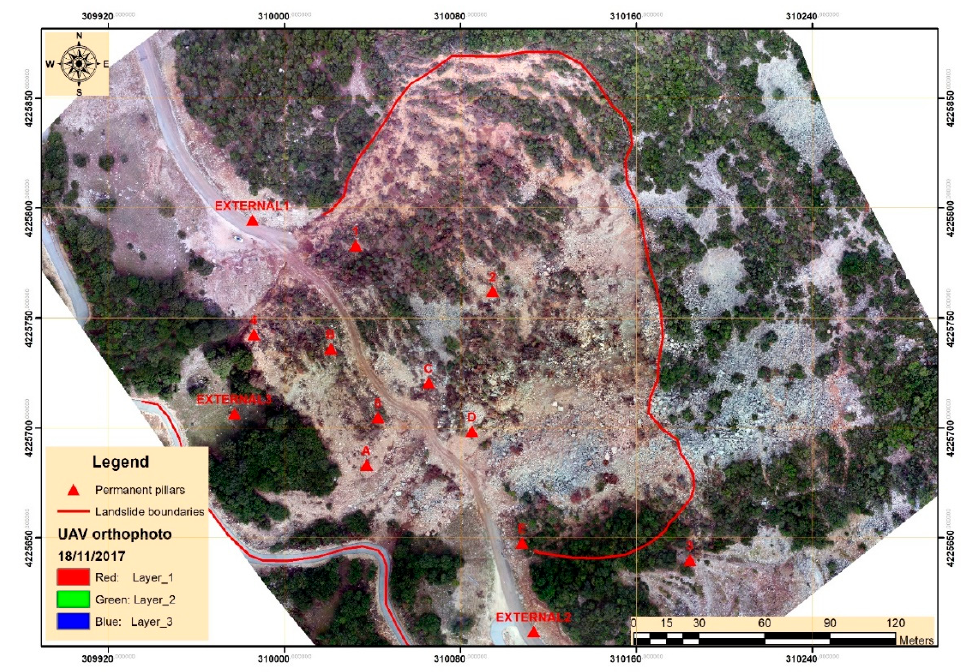
Figure 4. Locations of the permanent pillars.